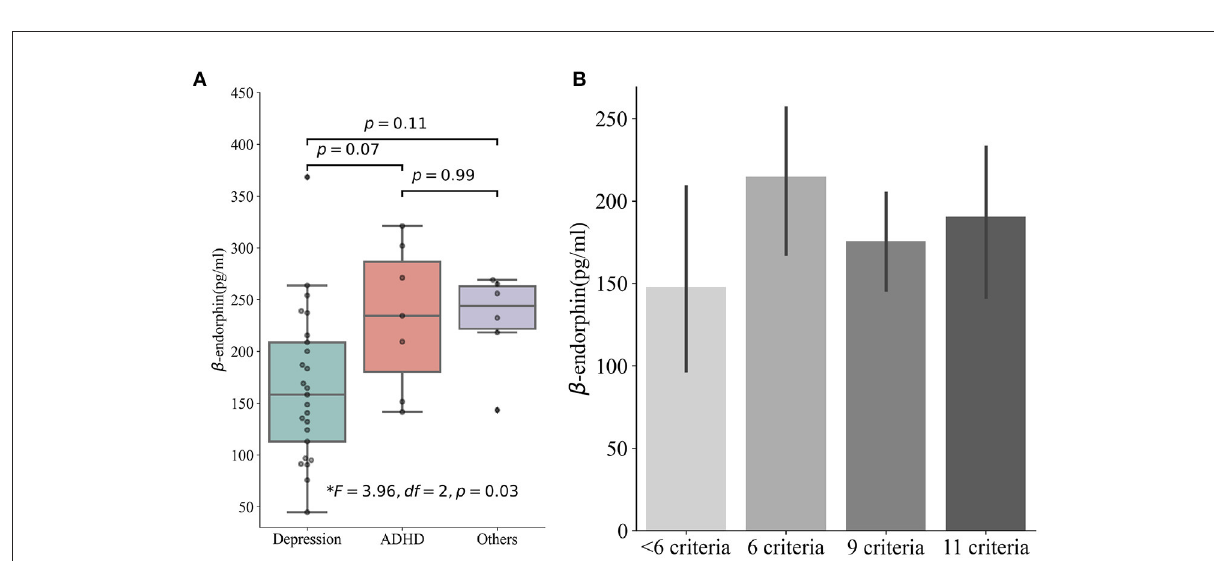
FIGURE2 (A) Patients with different clinic diagnoses and their differences in serum beta-endorphins. (B) Patients met different SIB addiction criteria and their differences in serum beta-endorphins. SIB, self-injurious behavior.